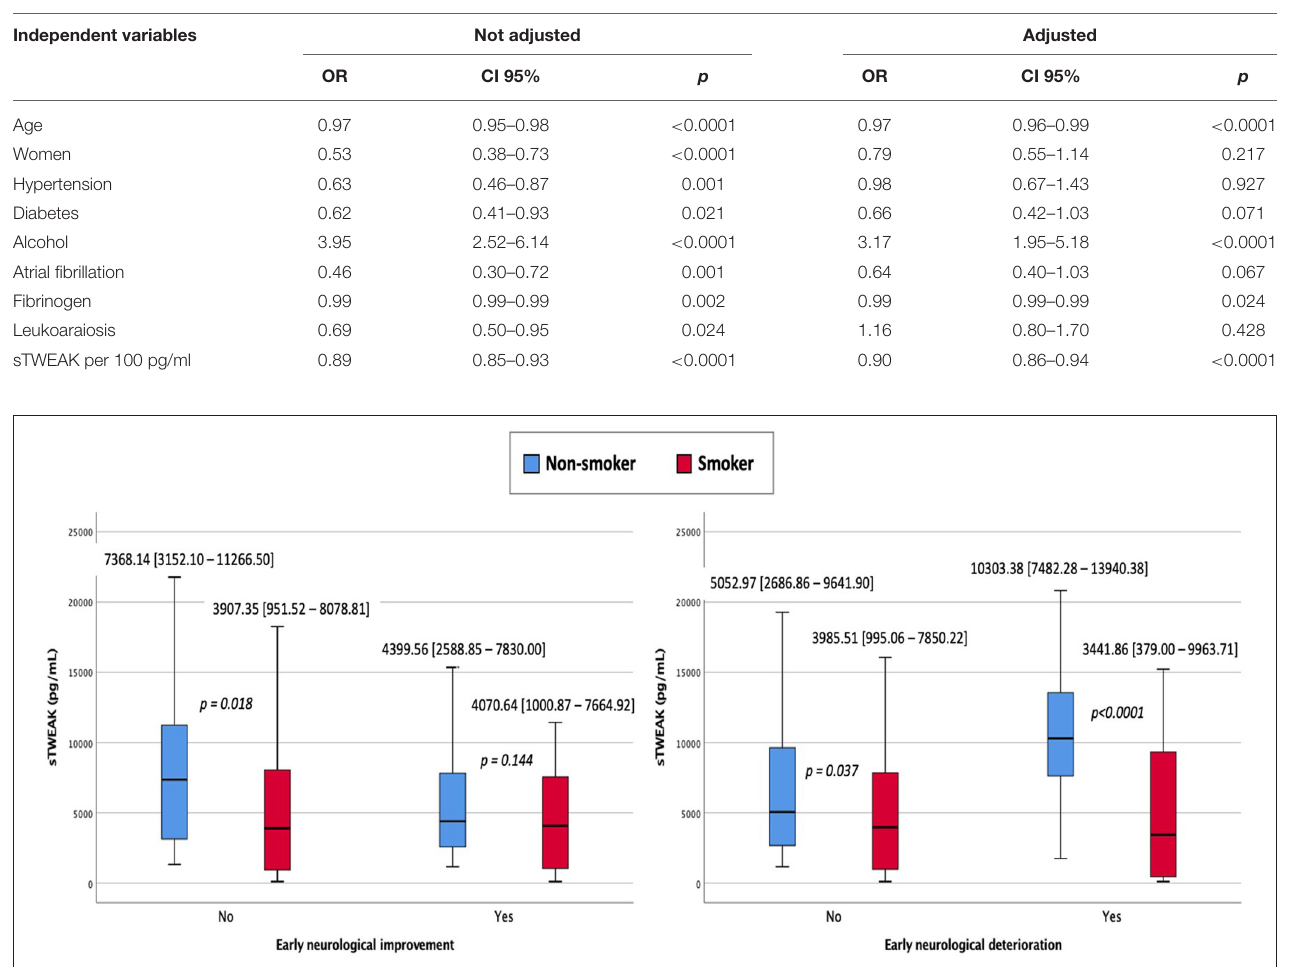
FIGURE 4 | sTWEAK concentrations in smoker and non-smoker patients who presented early neurological improvement and early neurological